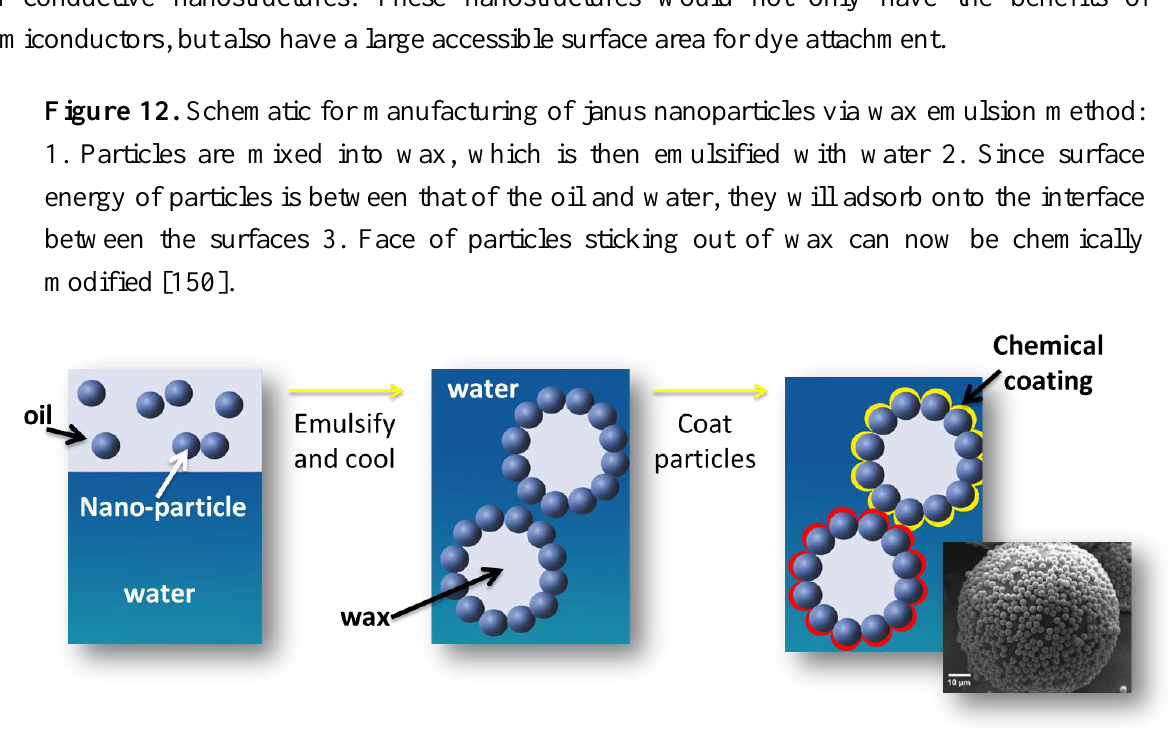
Janus nanoparticle, containing a 2